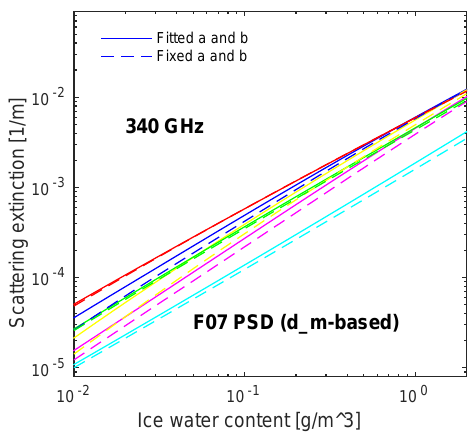
Figure 13. As in Fig. 12 but for 340GHz. The results for MH97 are not shown as they show the same general pattern as in Fig. 12 (just shifted in mean level in the same way as the results for